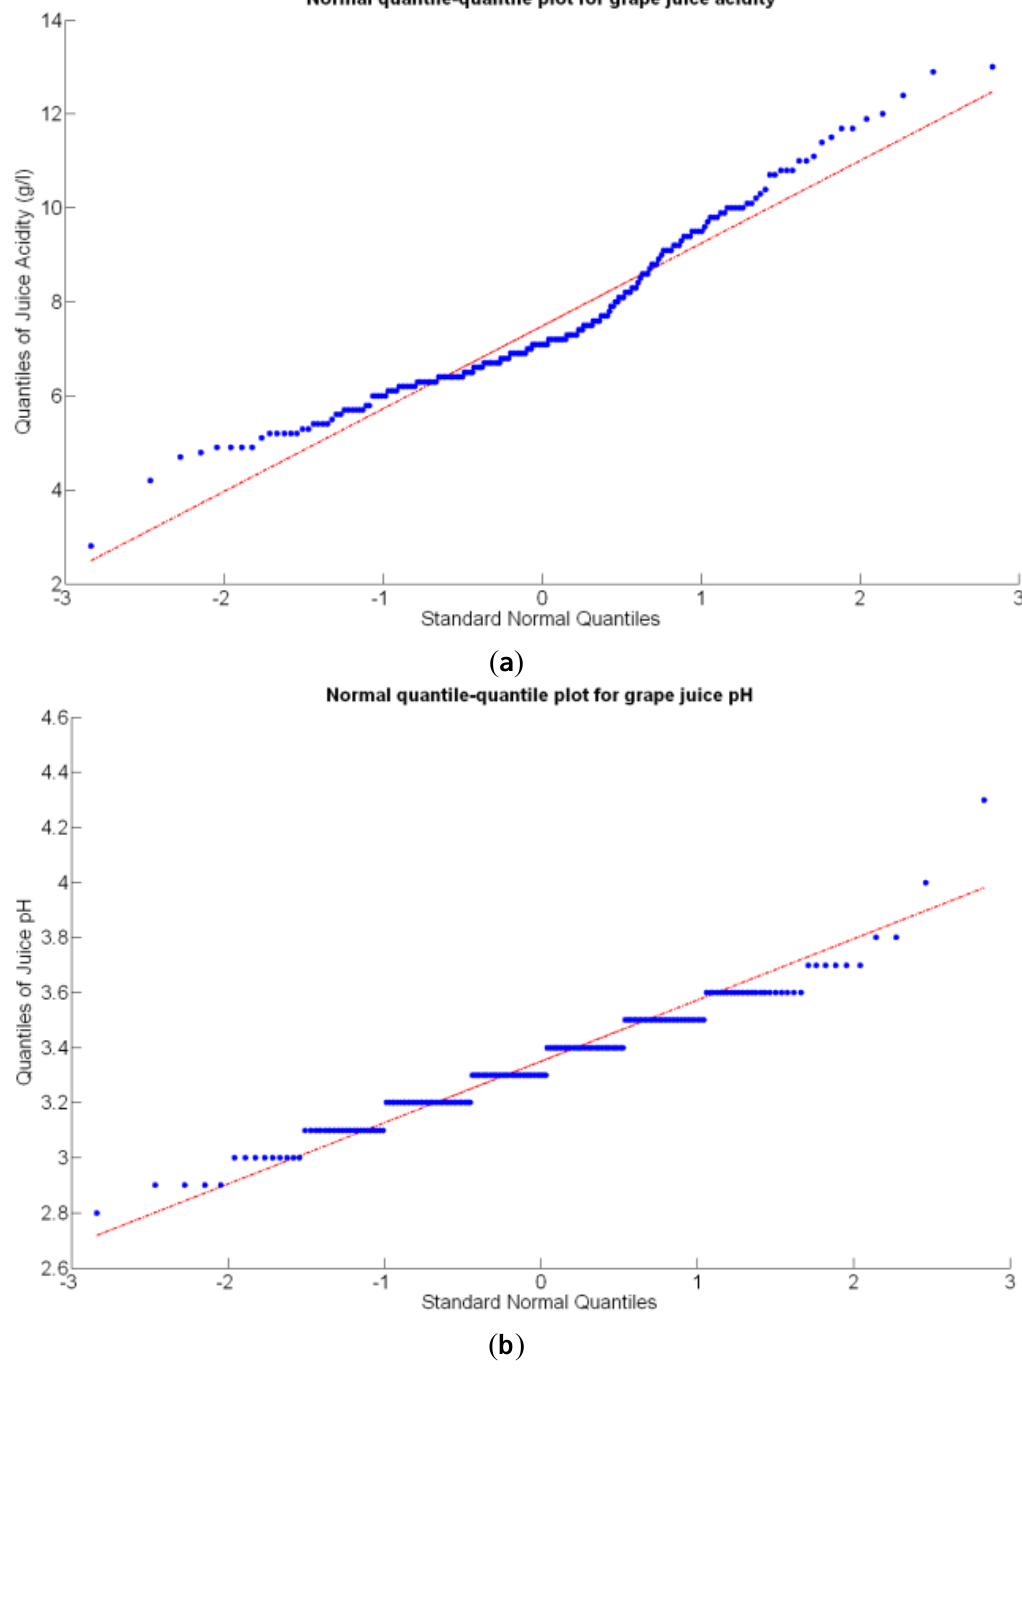
Figure 19. Normal quantile-quantile plots for must acidity: ( a ) Total acidity (g/L); ( b )